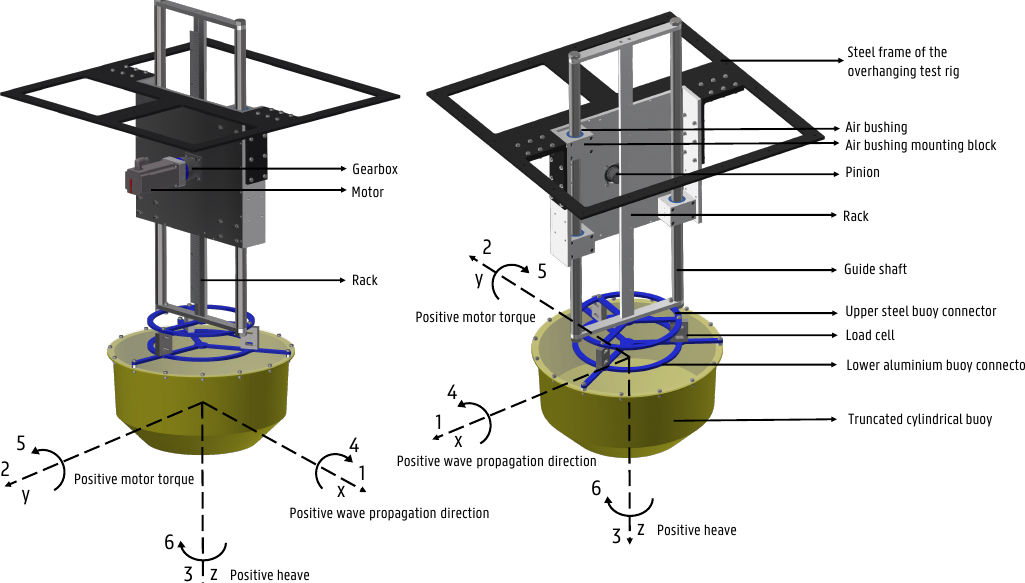
Figure 1. Rendering of the ‘WECfarm’ WEC, made with Autodesk Inventor (Autodesk, San Rafael, CA,